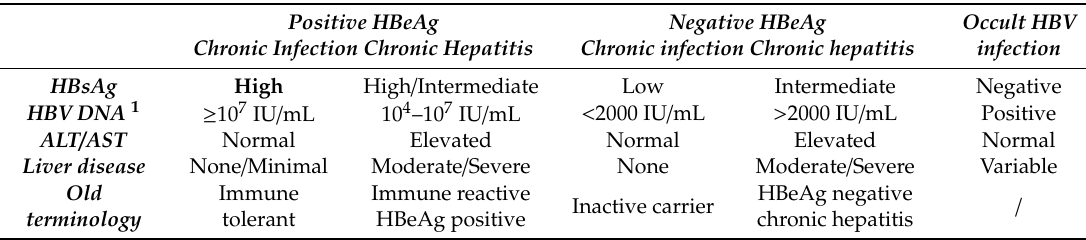
Table 1. New classification of the phases of HBV